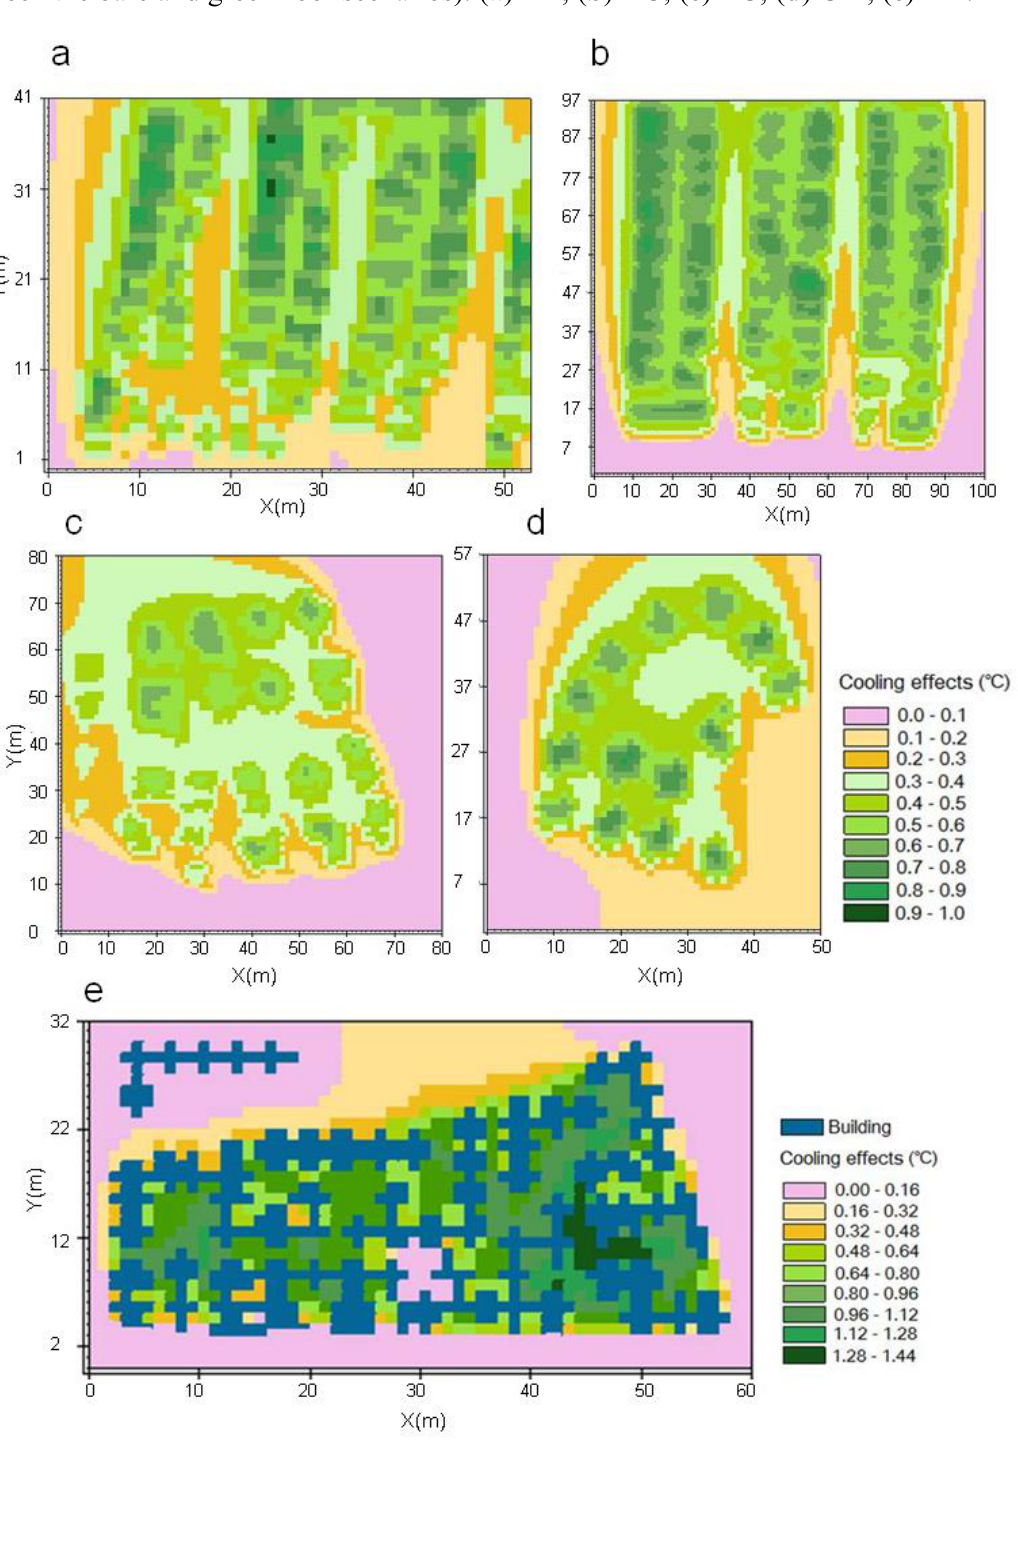
Figure 5. Horizontal distribution of cooling effects for extensive green roof (EGR) at the rooftop-podium level at 14:00 (cooling effects refer to the air-temperature differences between the bare and green-roof scenarios). ( a ) KT; ( b ) KC; ( c ) BC; ( d ) CM; ( e )